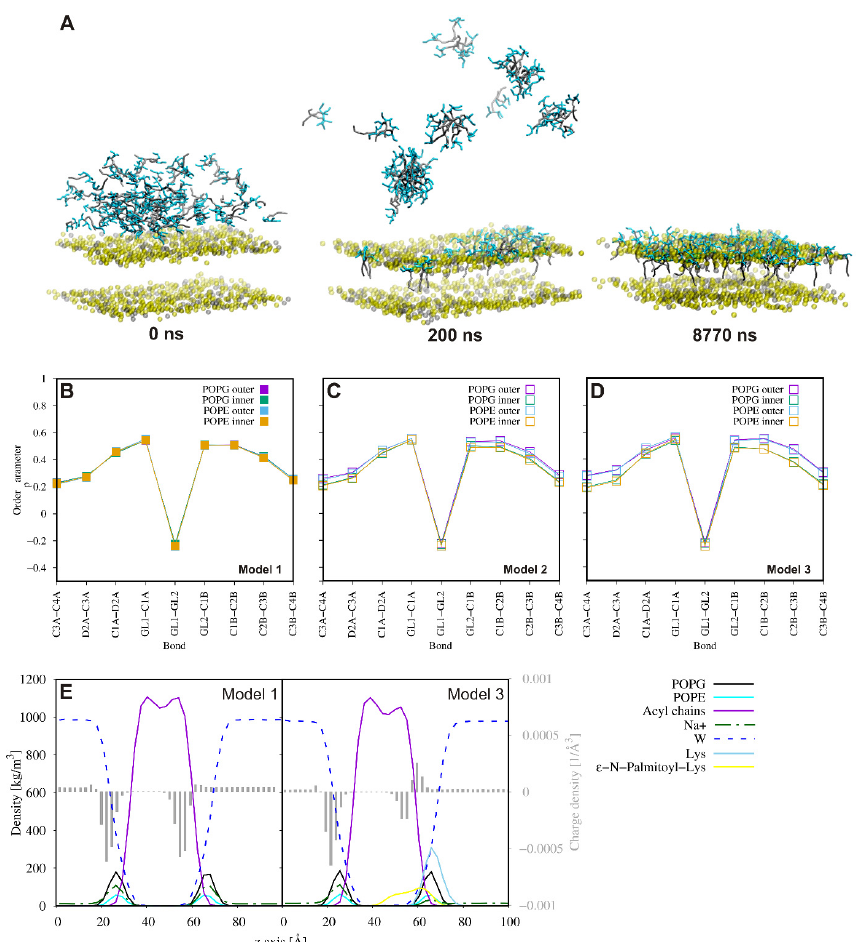
Figure 6. Representative snapshots from the 1-palmitoyl-2-oleoyl- sn -glycero-3-[phospho-rac-(1-glycerol)] (POPG)/1-palmitoyl-2-oleoyl- sn -glycero-3-phosphatidylethanolamine (POPE) binding course-grained molecular dynamic (CG MD) simulations for KK(K C16 )KK-NH 2 . For clarity, only phosphate beads of the membrane have been displayed. The POPE and POPG phosphate groups are indicated by the colors gray and yellow, respectively. Fatty acid tails are in gray, while lysine residues are in cyan ( A ). Comparison of the lipid acyl chain order parameters of the lipids in the outer and inner leaflet of the membrane in the absence of lipopeptide ( B ) and with the lipopeptide at two concentrations ( C , D ). Partial density and charge density profiles averaged over the last 100 ns of the CG MD simulations ( E ).